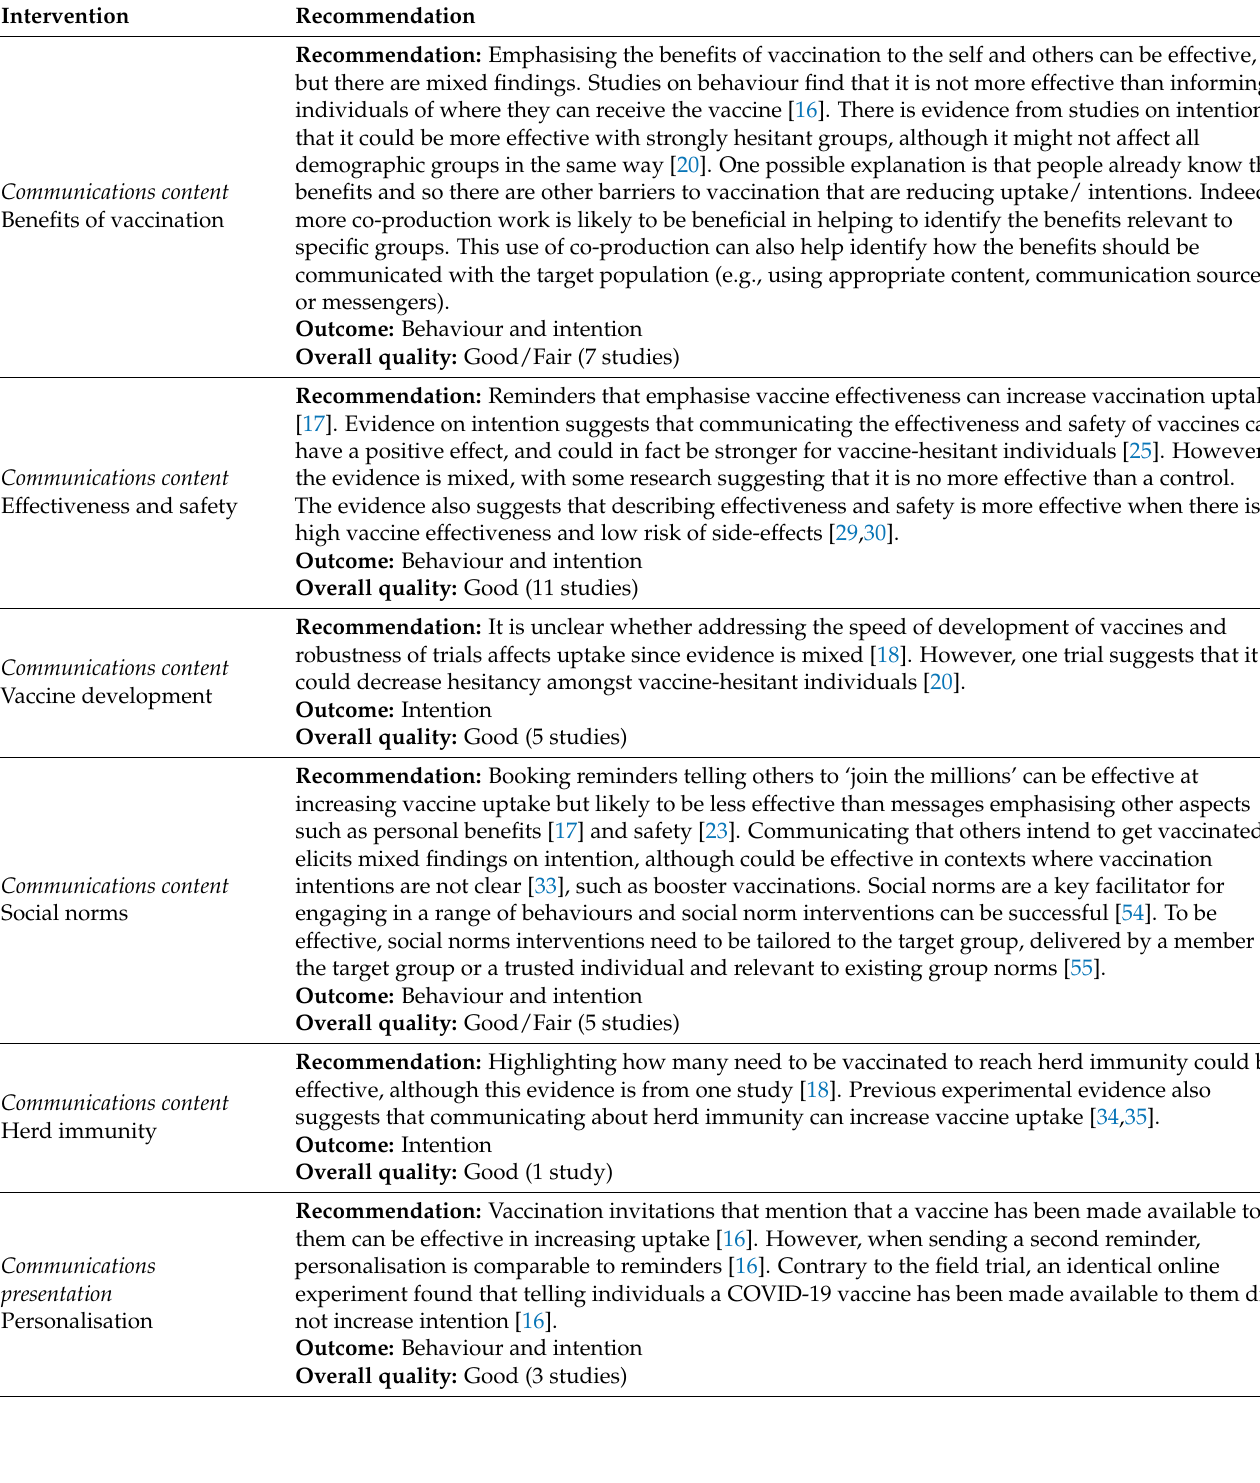
Table 2. Recommendations for increasing